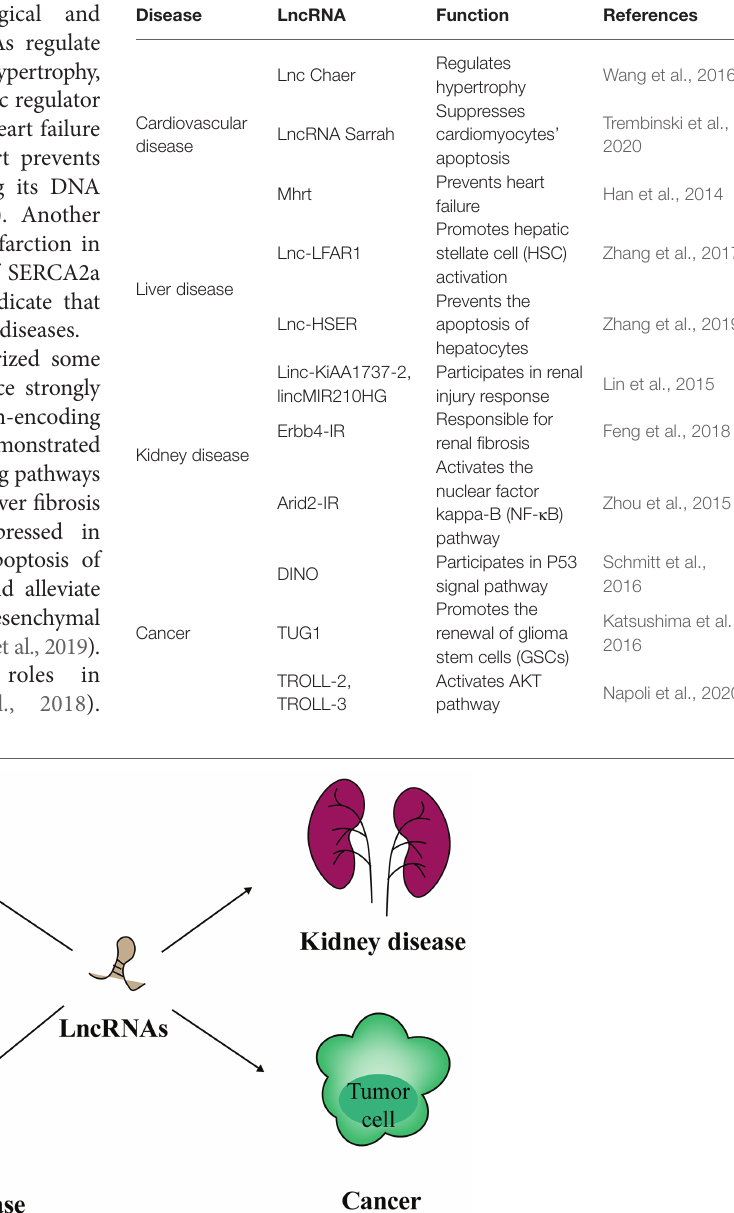
TABLE 1 | Key roles of LncRNAs in the